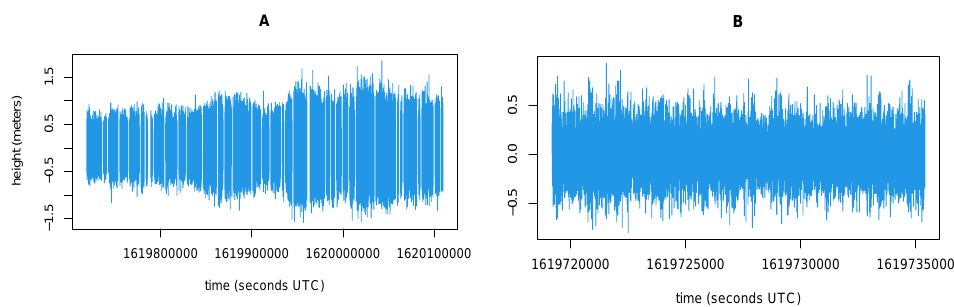
Figure 2. (Panel A ): Representation of the studied time series for buoy 28. The voids represent unobserved data. (Panel B ): Representation of the first observed segment of the time series in (Panel A ). Height in meters and time in seconds UTC.